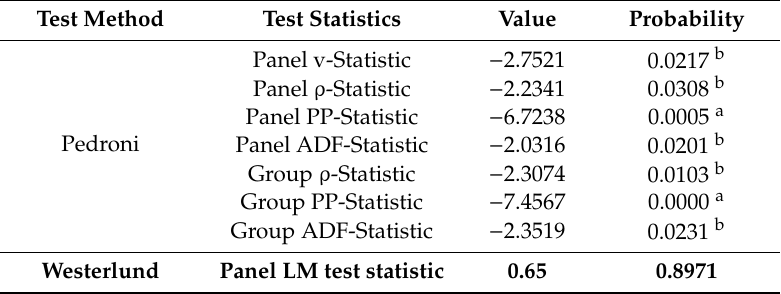
Table 5. Panel co-integration examination